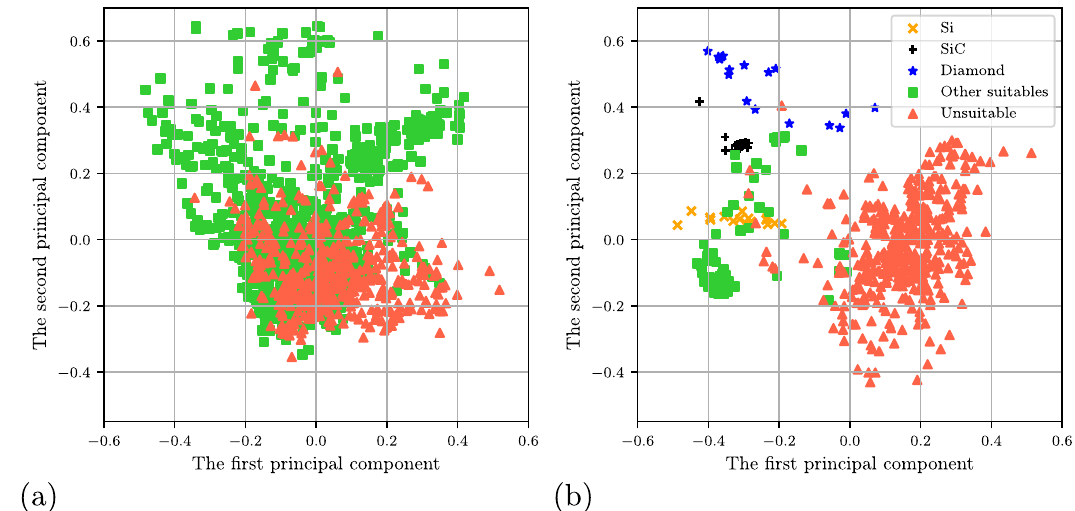
Fig. 4 Two-dimensional scatter plots. Scatter plots for the ( a ) criteria-based and ( b ) empirical approaches. The eigenvectors corresponding to the two largest eigenvalues of the covariance-matrix were identi fi ed, that is, the two most important principal components of the initial data from the Materials Project query. Then, the labeled datasets were transformed and visualized as 2D scatter plots. Green squares display suitable candidates, along with the black (SiC), blue (diamond) and yellow (Si) symbols for the empirical approach, and red triangles represent unsuitable